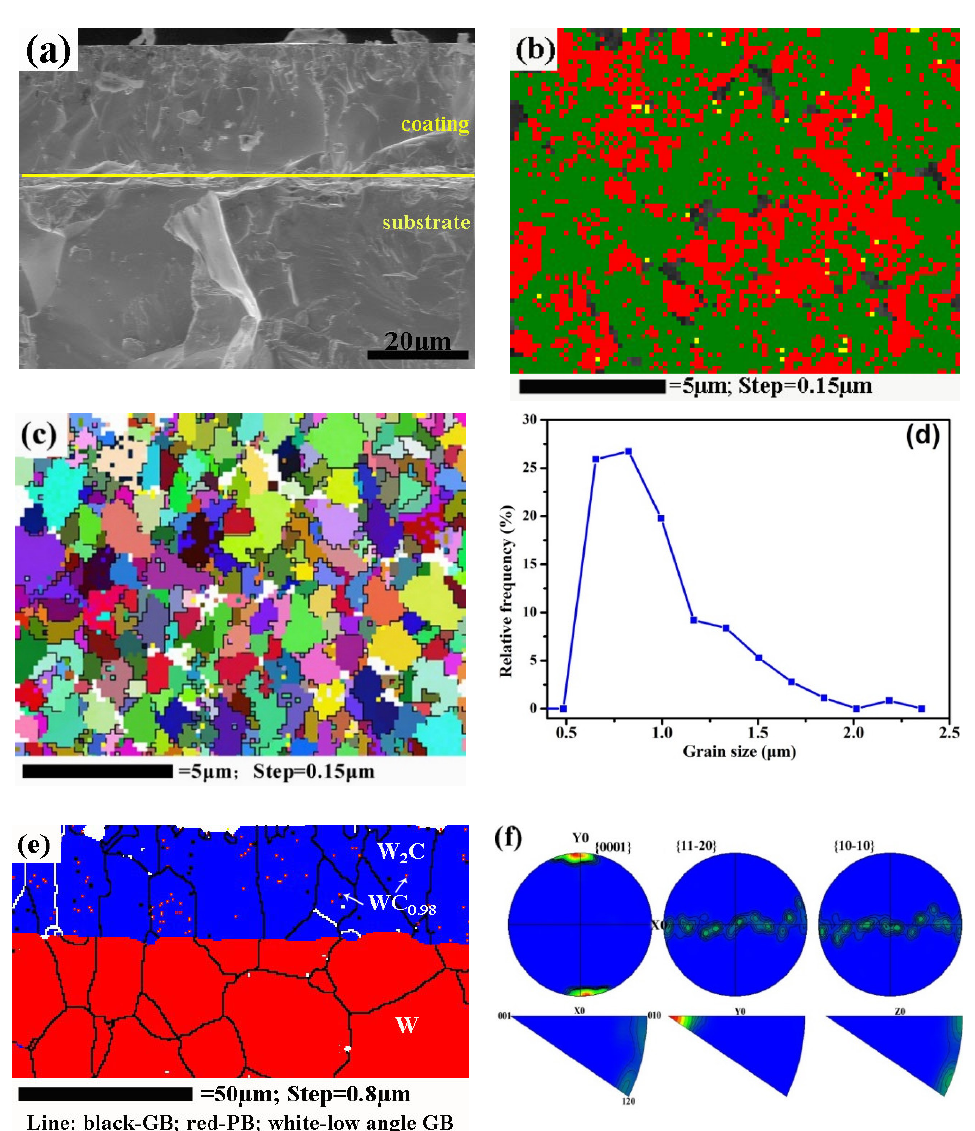
Figure 2. ( a ) Scanning electron microscopy (SEM) image of the cross-section of coating; ( b ) phase distribution of the coating surface (an indexing rate of about 91%, the black refers to the unindexed sites, the red to the WC phase, the green to WC 0.98 , the yellow to Cr 7 C 3 ); ( c ) Euler image and ( d ) grain PB: phase boundary); ( f ) pore figure and inverse pore figure of the inner size distribution of the WC and WC 0.98 phases; ( e ) phase distribution of the inner coating (the blue refers to the W 2 C phase, the red to the W substrate, the pink dots are the WC 0.98 phases; GB: grain boundary; PB: phase boundary); ( f ) pore figure and inverse pore figure of the inner coating.